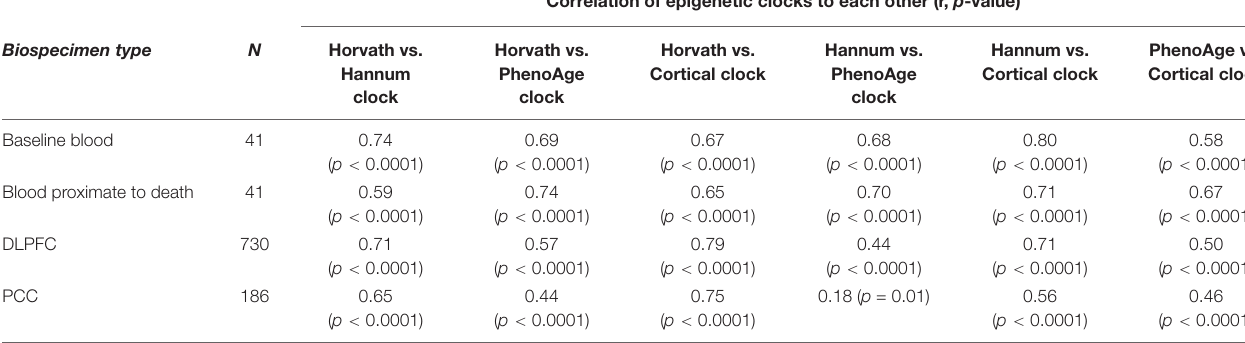
TABLE 3 | Pearson correlations of epigenetic clocks to each other, by specimen type. Correlation of epigenetic clocks to each other (r, p